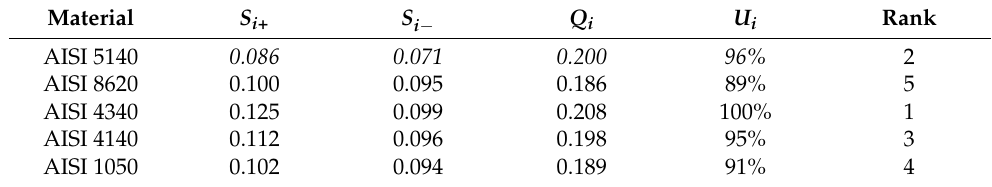
Table A10. COPRAS